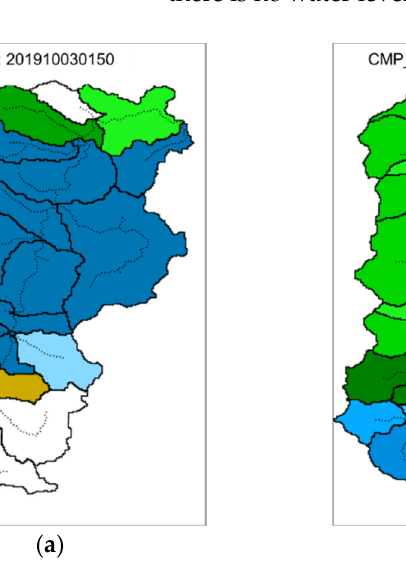
Figure 8. Mean areal precipitation of the Samcheok-osib stream (3 October 2019, at 01:50): ( a ) Ground rain gauge; ( b ) CMP_HFC; ( c ) SAM_RR.